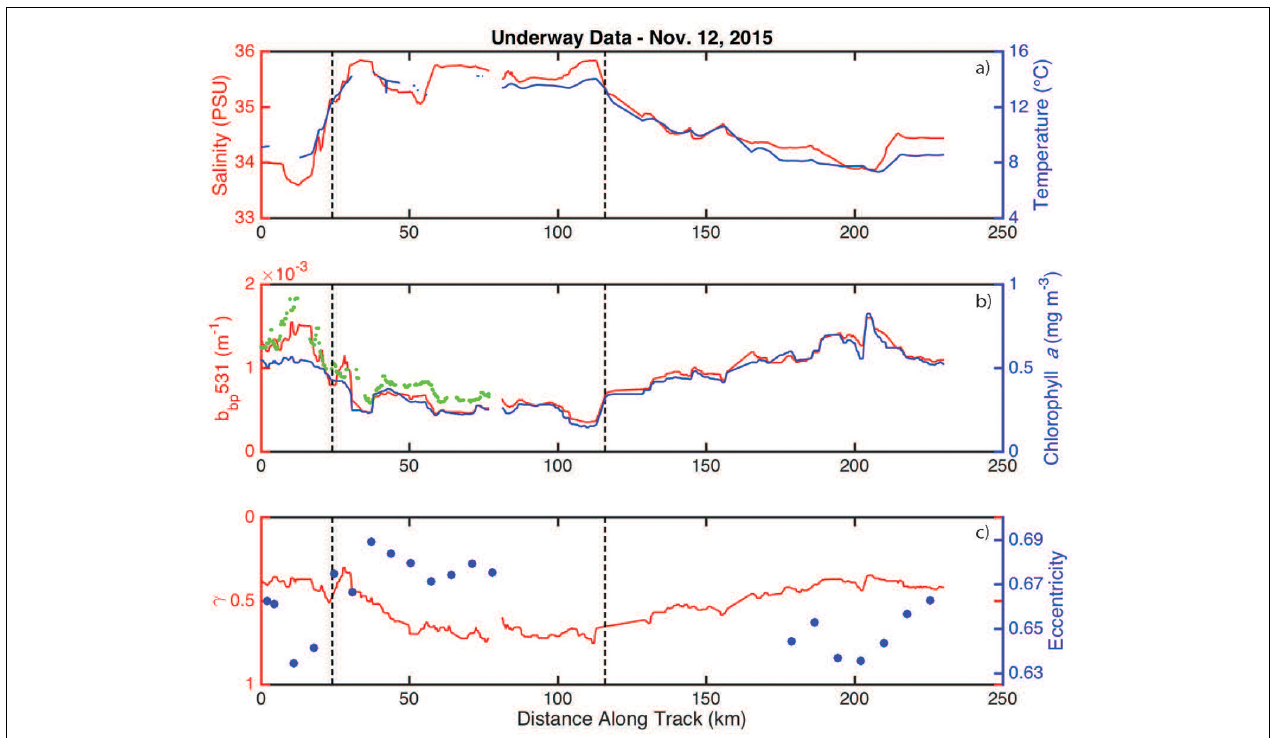
FIGURE 4 | Underway measurements collected along the November 12, 2015 ship track. (a) Salinity and temperature are shown in red and blue, respectively. The eddy boundaries (defined using the derivative of b bp ) are indicated by the vertical hashed lines. (b) b bp and chlorophyll- a concentrations are shown in red and blue, respectively. The green dots are the available ECO-BB3 measurements. (c) The size index parameter ( γ ) and average particle eccentricity are shown in red and blue,